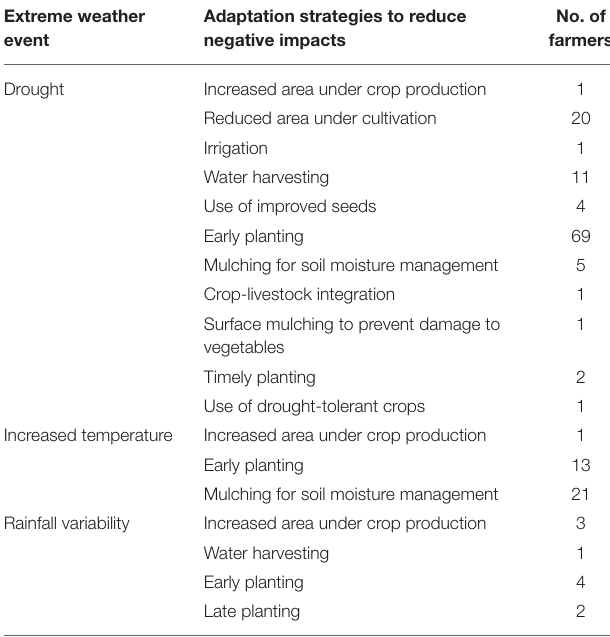
TABLE 3 | Extreme events associated with climate change and variability, and related adaptation strategies adopted by the 202 farmers surveyed.